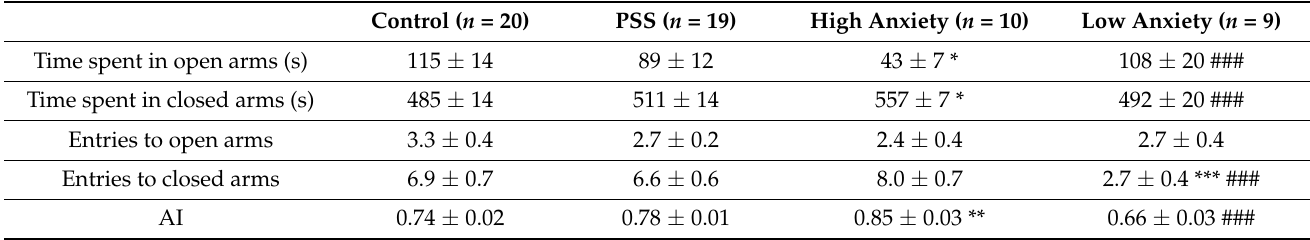
Table 1. Results of EPM behavioral experiments.